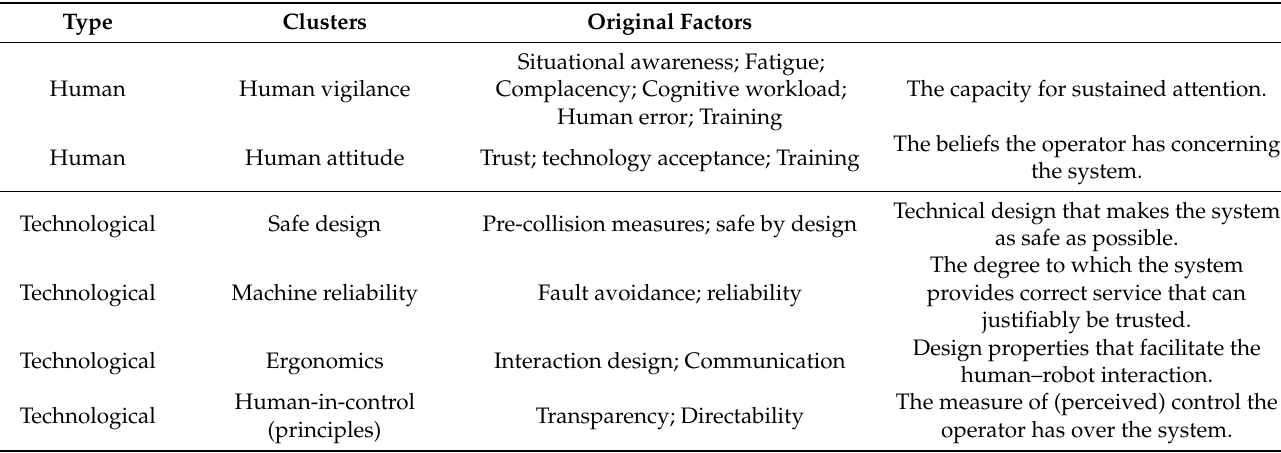
Table 3. Clusters in the final